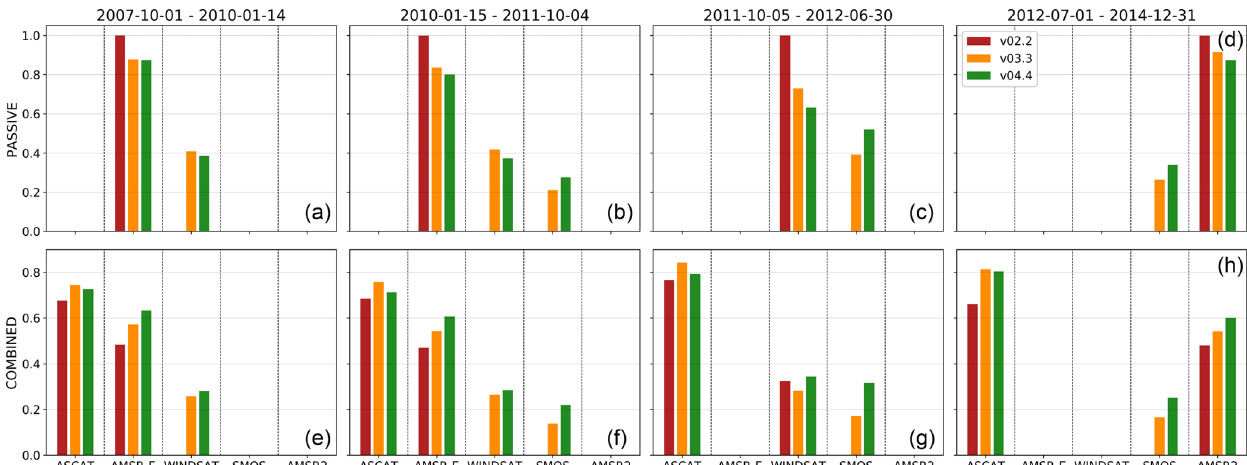
Figure 11. Fractional contribution ( y axis) of the individual sensors ( x axis) to valid ESA CCI SM soil moisture estimates of the PASSIVE and COMBINED products (top to bottom) during the last four merging periods (left to right). Bar colours refer to the ESA CCI SM product versions v02.2, v03.3 and